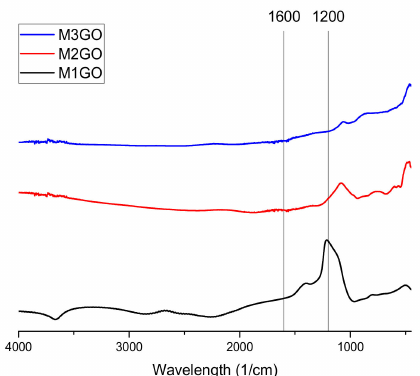
Figure 2. Fourier-transform infrared spectroscopy (FTIR) spectra of the examined graphene oxide powder of samples S 1 GO, S 2 GO, and S 3 GO as shown in Table 1.